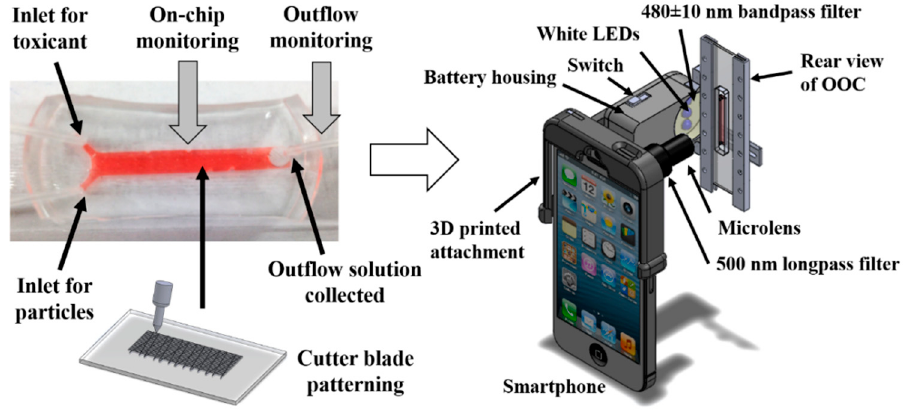
Figure 10. Schematic of how microscope-attachment based smartphone microscopy can be used to monitor both membrane expression and protein product release in a kidney on a chip device. Reprinted from [4] with permission. © 2016 Elsevier.